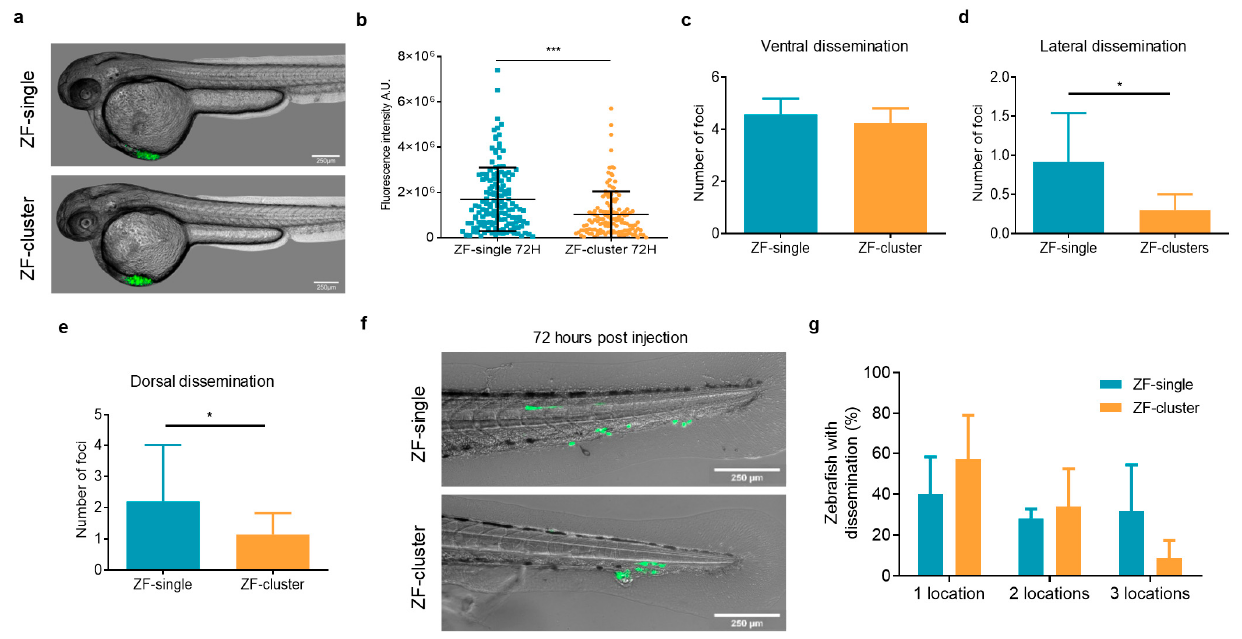
Figure 2. Functional characterization of single and cluster models in zebrafish xenografts. ( a ) Representative images of zebrafish showing tumor cell injection at the perivitelline space, near the convergence with the Duct of Cuvier (scale bar 250 μ m); ( b ) Dot plot of the integrated fluorescence intensity in the tail of ZF ‐ single and ZF ‐ cluster 72 h after injection ( n = 6 independent experiments). Each dot represents an individual fish; Number of foci found in the ( c ) ventral, ( d ) lateral, and ( e ) dorsal areas of the zebrafish tails; ( f ) Representative images of disseminated cells in the tails of ZF ‐ single and ZF ‐ cluster xenografts at 72 h post ‐ injection (scale bar 250 μ m); ( g ) Percentage of ZF ‐ single and ZF ‐ cluster xenografts with one, two, or three dissemination locations in the tail. * p < 0.05, *** p < 0.001.